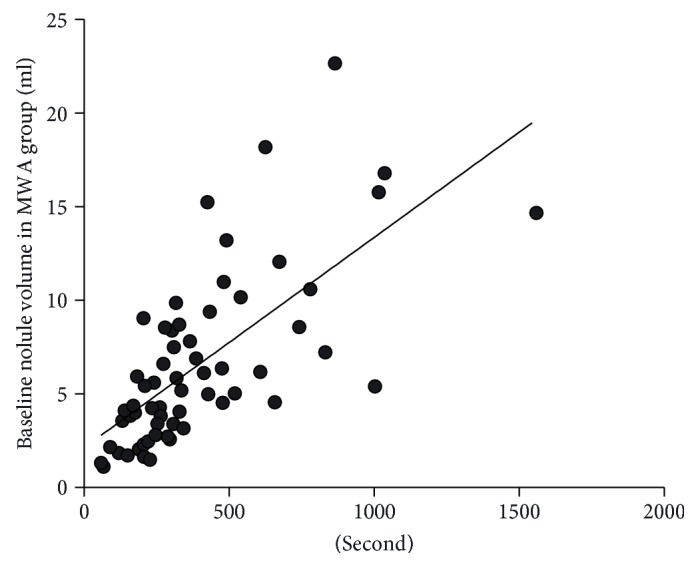
Positive correlation between ablation time and index nodule volume. Y = 0.011x + 2.12; r2 = 0.472; p < 0.001.